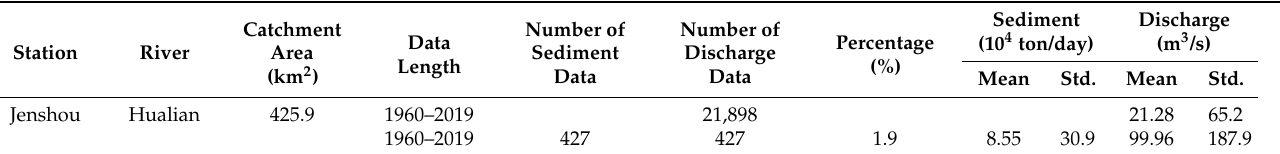
Table 2. Basic information of suspended sediment load and discharge data at Jenshou station in Taiwan. Catchment Station River